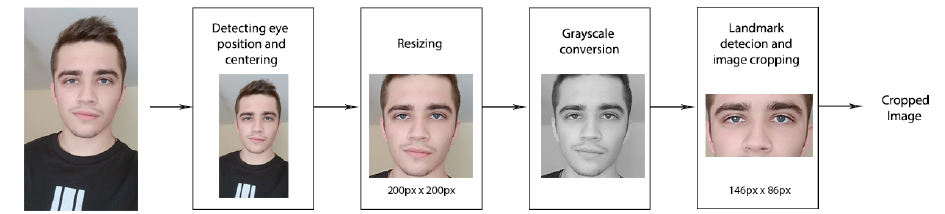
Figure 2. Preprocessing block